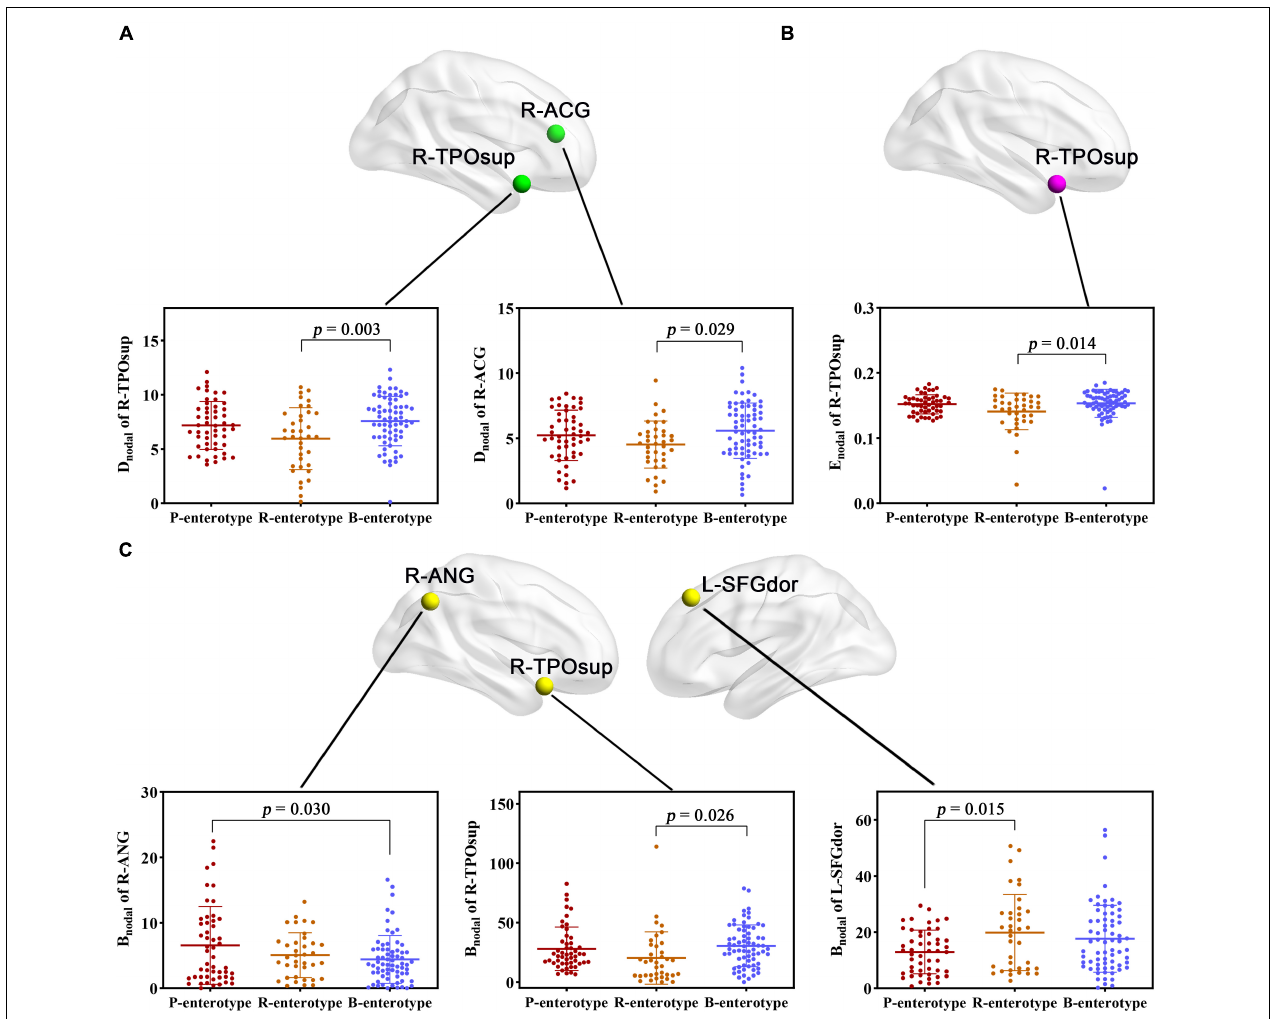
FIGURE 6 | (A–C) Inter-group comparisons in regional topological metrics of FC across enterotypes. Spatial maps show the significantly different nodes (i.e., brain regions). ACG, anterior cingulate and paracingulate gyri; ANG, angular gyrus; B nodal , nodal betweenness; D nodal , nodal degree centrality; E nodal , nodal efficiency; L, left; R, right; SFGdor, dorsolateral superior frontal gyrus; TPOsup, temporal pole: superior temporal